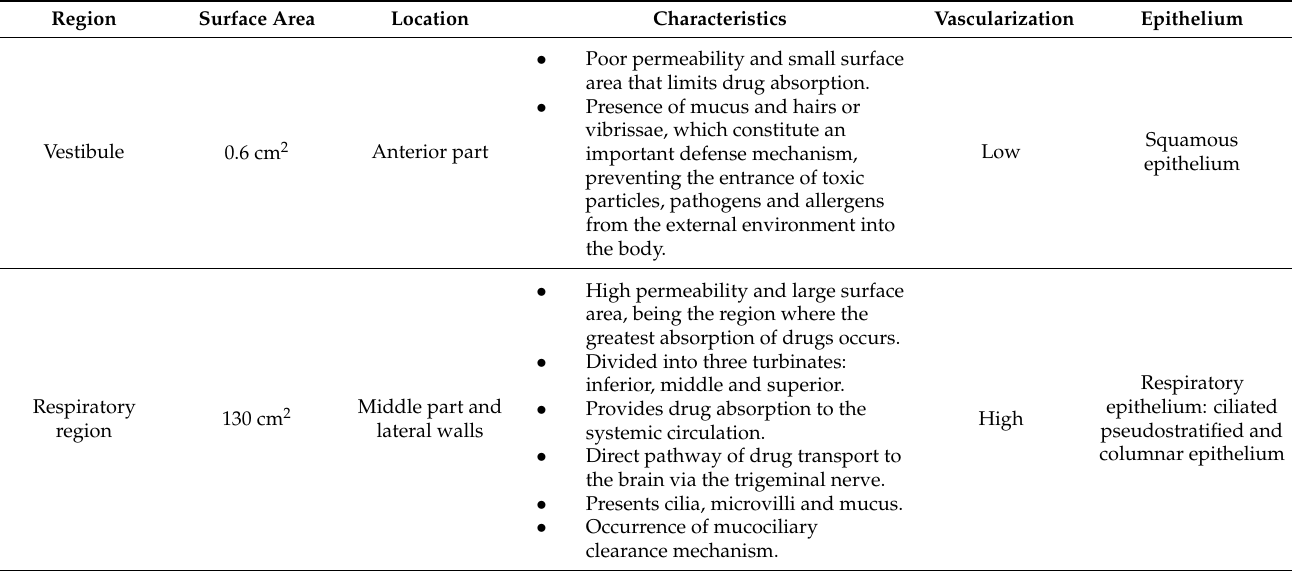
Table 1. Characteristics of the different regions of the nasal cavity (data from [3,9,13,15–17]). Region Surface